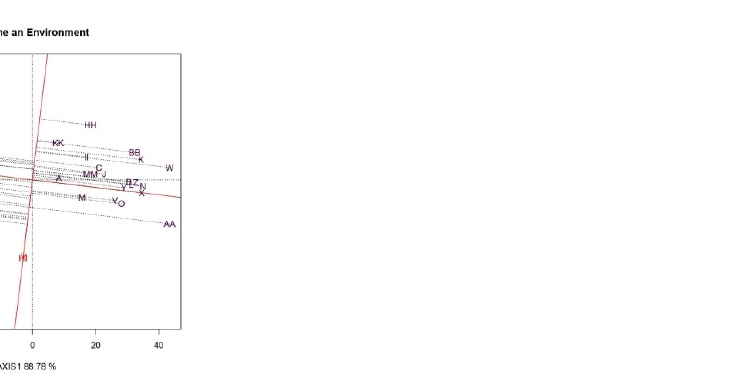
Figure 4. Bioplot diagrams of genotype + genotype x environment (GGE) for all traits studied. Plotting parameters were Transform = 0, Scaling = 0, Centered = 2, SVP = 2.